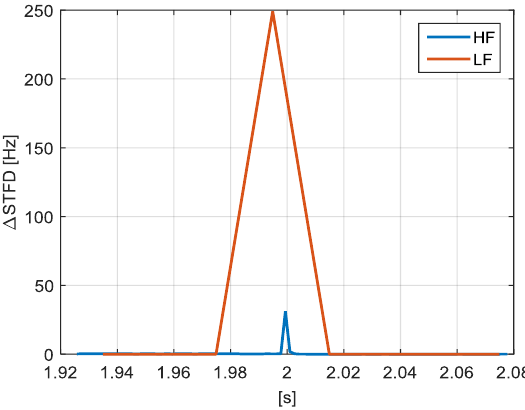
Figure 19. Case study 3: STDE at low-frequency (0 ÷ 2.4 kHz, red line) and at high-frequency (2.4 ÷ 150 kHz, blue line) obtained through the instantaneous approach.